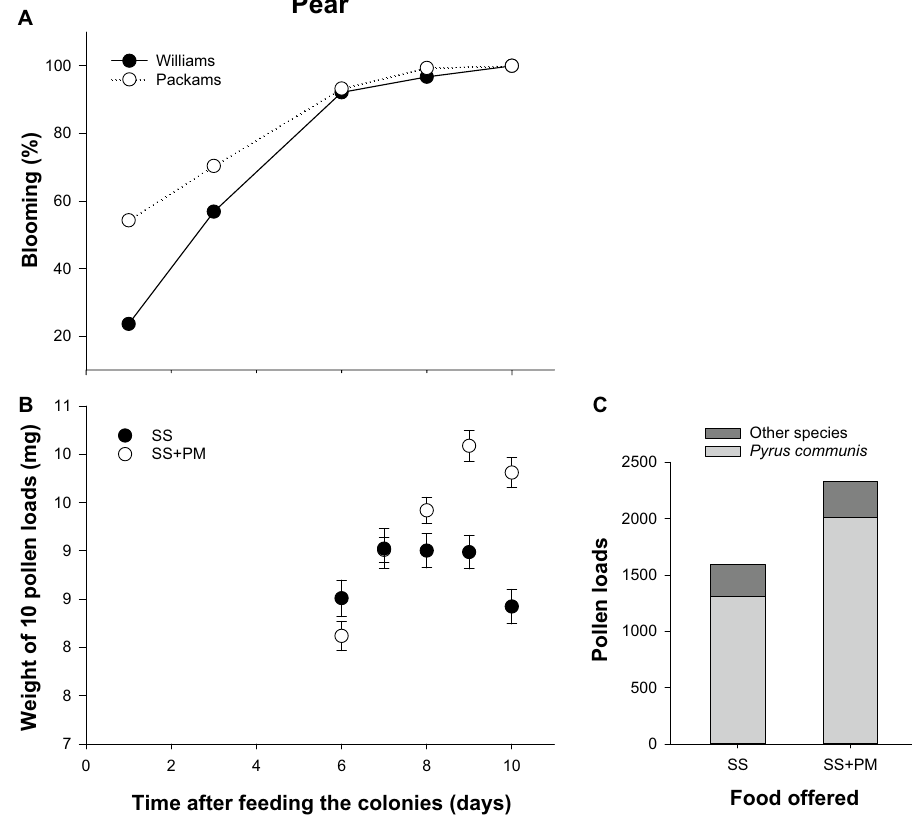
Figure 4. Effect of the pear mimic odour on the pollen foraging. ( A ) Percentage of blooming of the dominant variety of pear tree during the experimental period. As an example is shown one colony fed unscented sucrose solution (SS) and one colony pear mimic-scented sucrose solution (SS + PM). ( B ) Size of pear pollen loads trapped at the colony entrance is expressed in mg of 10 pollen loads along the experimental period. ( C ) Number of pollen loads accumulated during days 3, 7 and 8 after the offering of pear mimic-scented sucrose solution (SS + PM) or unscented sucrose solution (SS) for the same colonies. Pollen traps were placed in one colony treated of each treatment, the samples obtained were classified according to their colour into the categories: Pyrus communis (light grey bar) and pollen from other species (dark grey